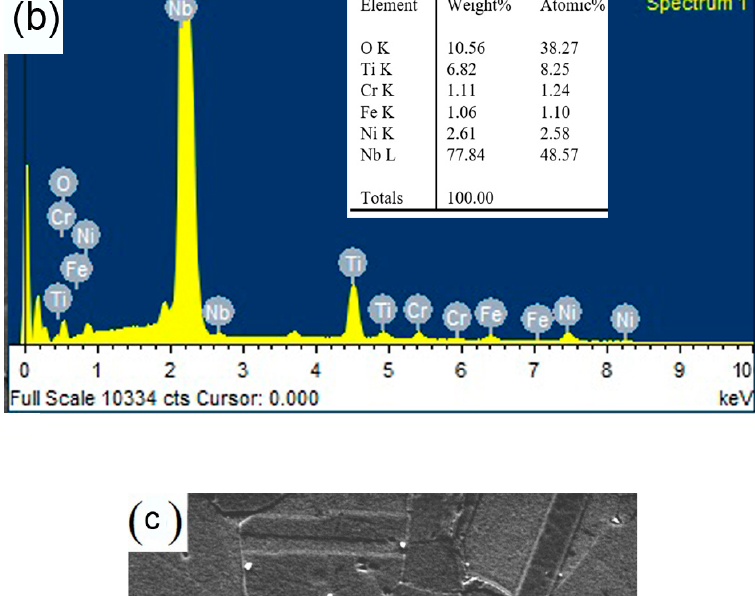
Figure 3. Scanning electron micrographs and EDS analysis of the precipitates in ( a , b ) Inconel 718 ST and ( c , d ) Inconel 718 STA base metals, respectively.